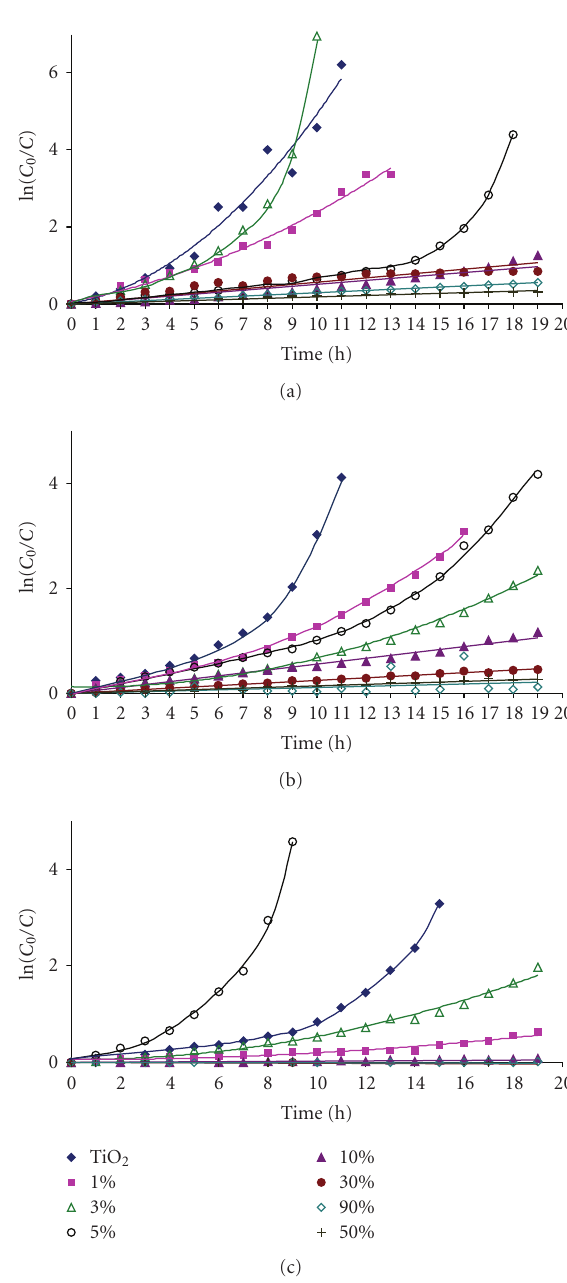
Figure 7: AR decomposition under Vis irradiation on TiO 2 and TiO 2 -WO 3 photocatalysts, (a) as received, (b) 400 ◦ C-treated, and (c) 600 ◦